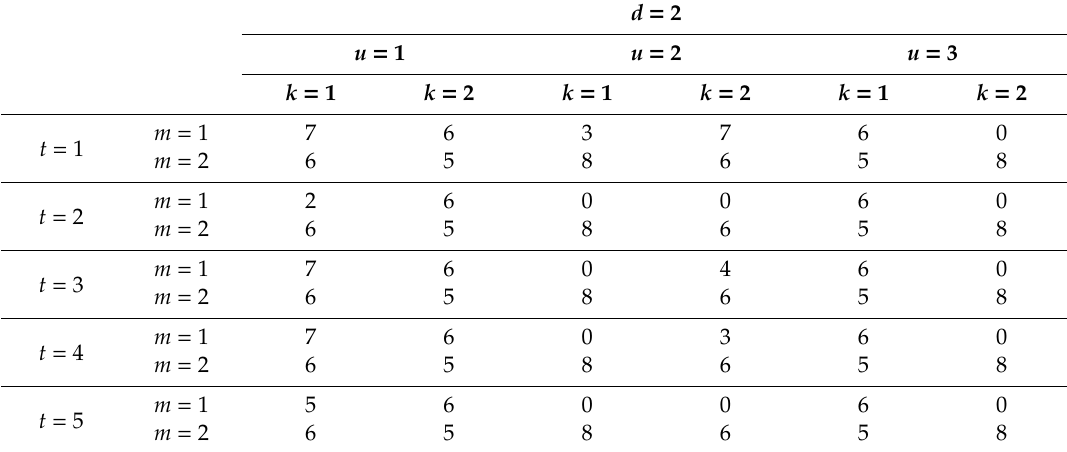
Table A2. Required number of each vehicle between manufacturers and distributor in period t = 2–5.